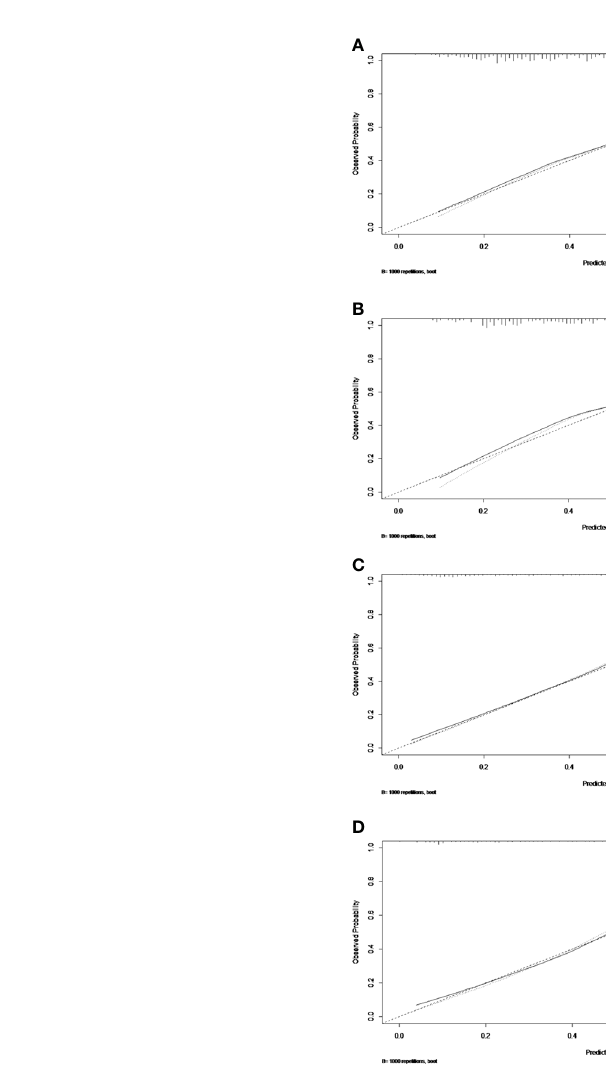
FIGURE 5 | The calibration curves of the PTFM nomogram in the training set (A) and test set (B) . The calibration curves of the ALNFM nomogram in the training set (C) and test set (D) . The 45-degree diagonal line demonstrates perfect matching between the nomogram-predicted probabilities (X-axis) and the true value (Y-axis). The distances were closer between the two lines, and the prediction accuracies of the ALNFM nomogram were higher than those of the